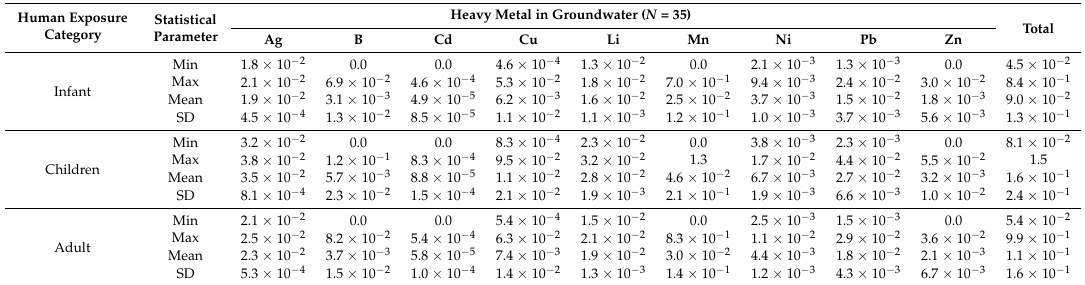
Table 4. Human exposure risk (mg/kg/day) due to heavy metals through the drinking water pathway. Human Exposure Category